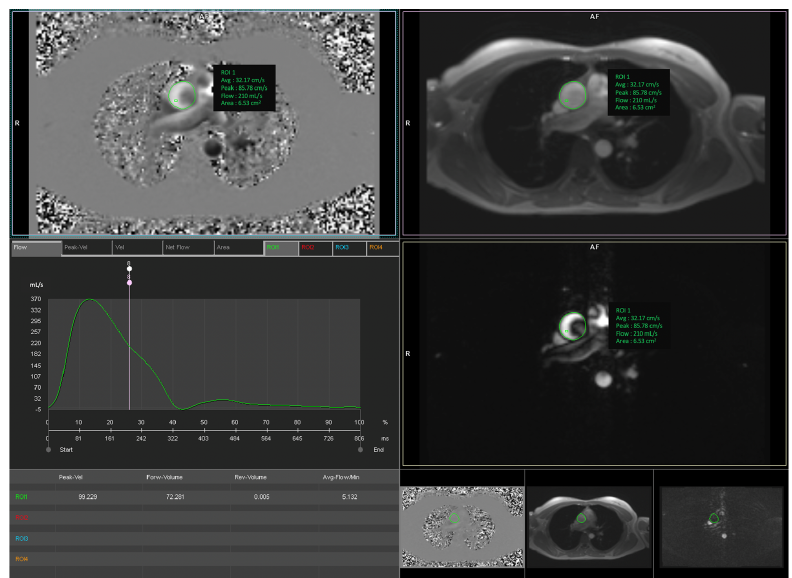
Figure 2. Placement of images for the major vessels, the resulting phase ‐ contrast flow image, and the calculated flow curve. The green circle is placed in the AAO in this figure. Flow quantification using Syngovia was semi ‐ automated. AAO: ascending aorta, DAO: descending aorta, LPA: left pulmonary artery, PA: pulmonary artery, RPA: right pulmonary artery, SVC: superior vena cava. Inter ‐ and intra ‐ observer reproducibility (single ‐ measure ICC) for all MRI flow quanti ‐ fication ranged from 0.826 to 0.983 and 0.866 to 0.999, respectively, as shown in Table 2. Table 2. Inter ‐ and intra ‐ observer ICC.